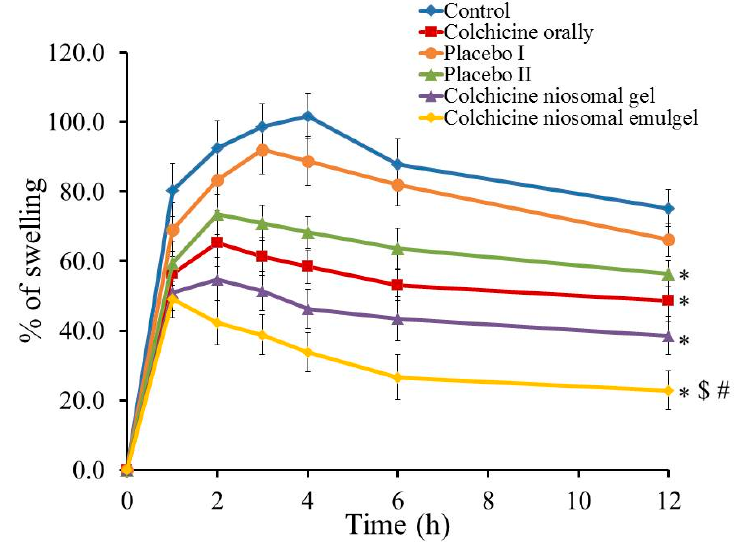
Figure 12. Effects of colchicine prepared in various formulations on percentage of swelling of carrageenan ‐ induced paw edema rats. Results are expressed as mean with the bar showing SD (n = 5).* p < 0.05 compared to non ‐ treated group (control); $ p < 0.05 compared to colchicine orally and # p < 0.05 compared to colchicine niosomal gel.